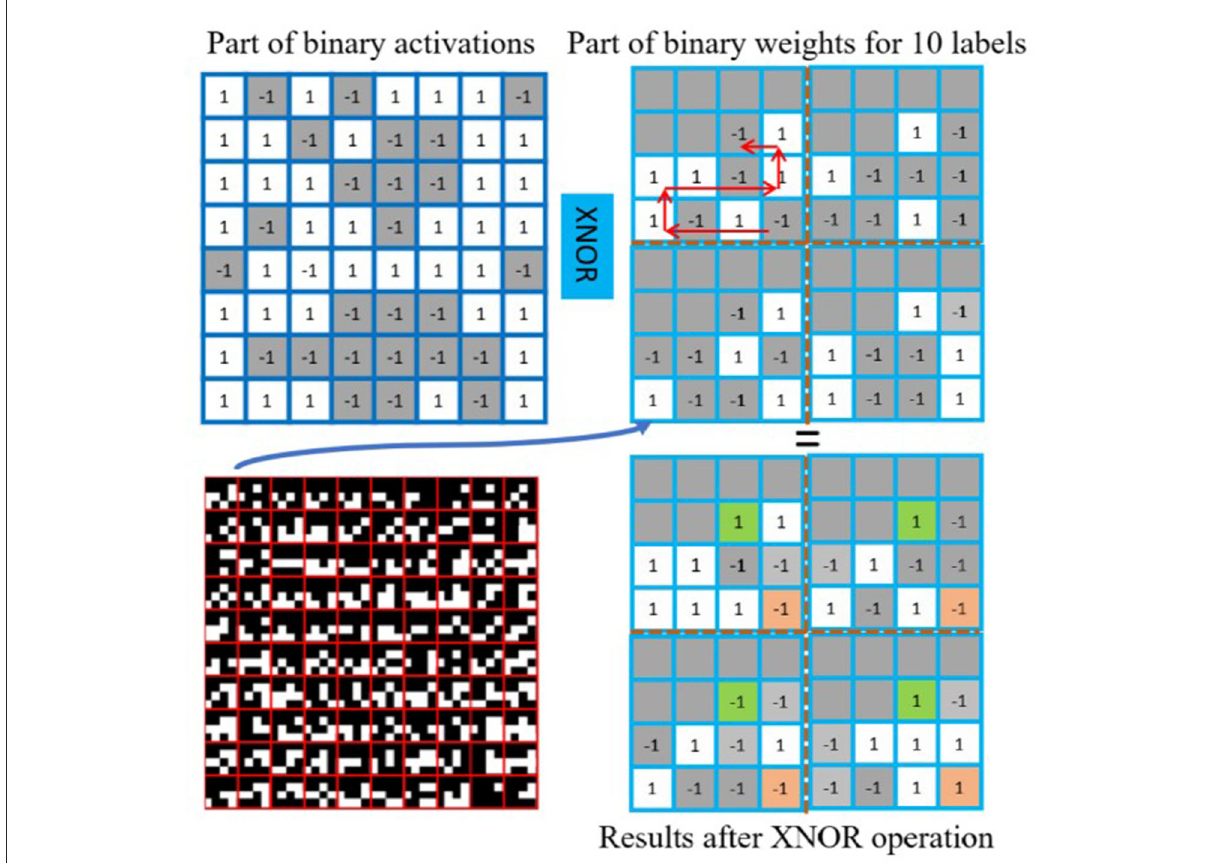
FIGURE6 Fully-connected layer implementation. The fully-connected layer on PPA uses parallel XNOR operation and bit counting. The binary weights for labels are stored on DREG in a specific order within a 4 × 4 box. For example, the results for label 0 can be obtained by counting the sum of values in orange boxes ( − 1 − 1 − 1 + 1 = − 2). The results for label 9 from green boxes (1 + 1 − 1 + 1 = 2).